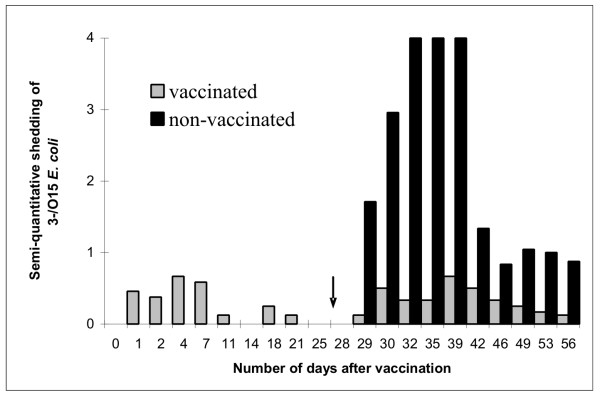
A semi-quantitative assessment of the shedding of the vaccine strain (before day 28) and wild-type strain (after day 28). The day of infection is indicated by the arrow. Grey bars represent the shedding by the vaccinated animals, black bars the shedding by the non-vaccinated rabbits (0 = no shedding, 4 = confluent colonies on agar plate).